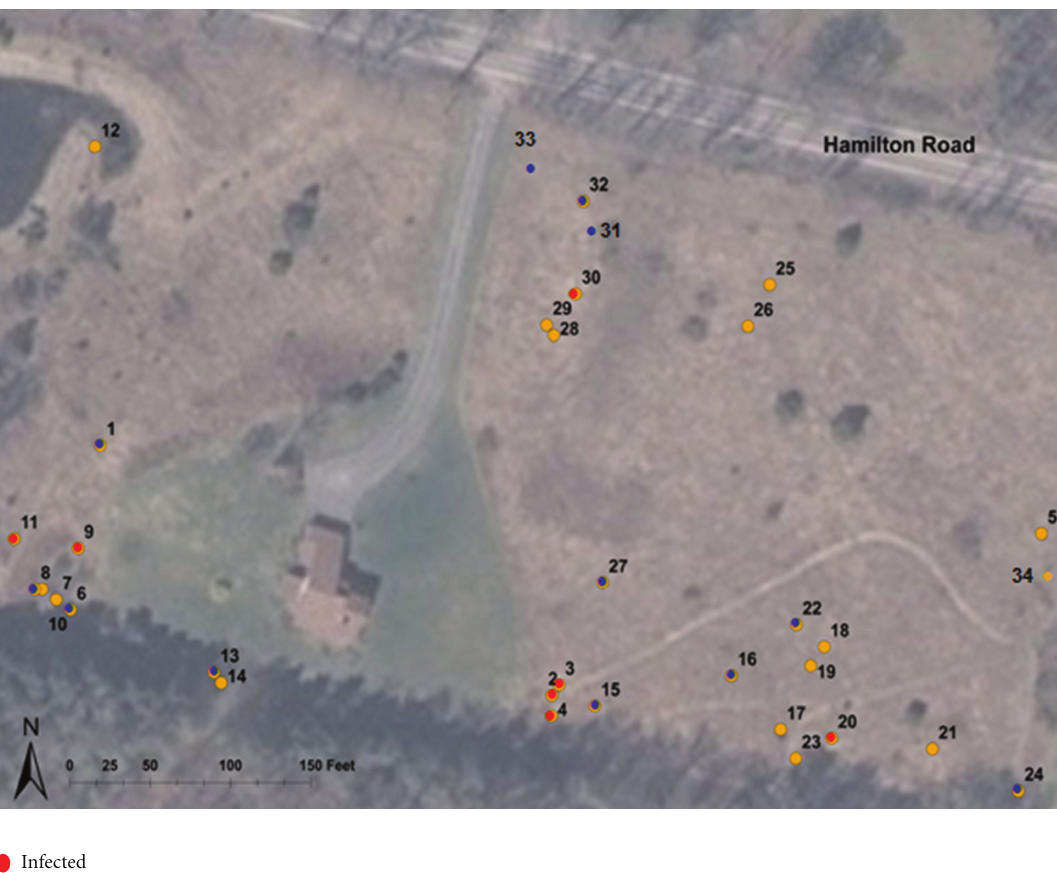
Figure 1: Map of the study site showing all colonies in the population. Infected colonies: red circles; noninfected colonies: blue circles; untested colonies: yellow